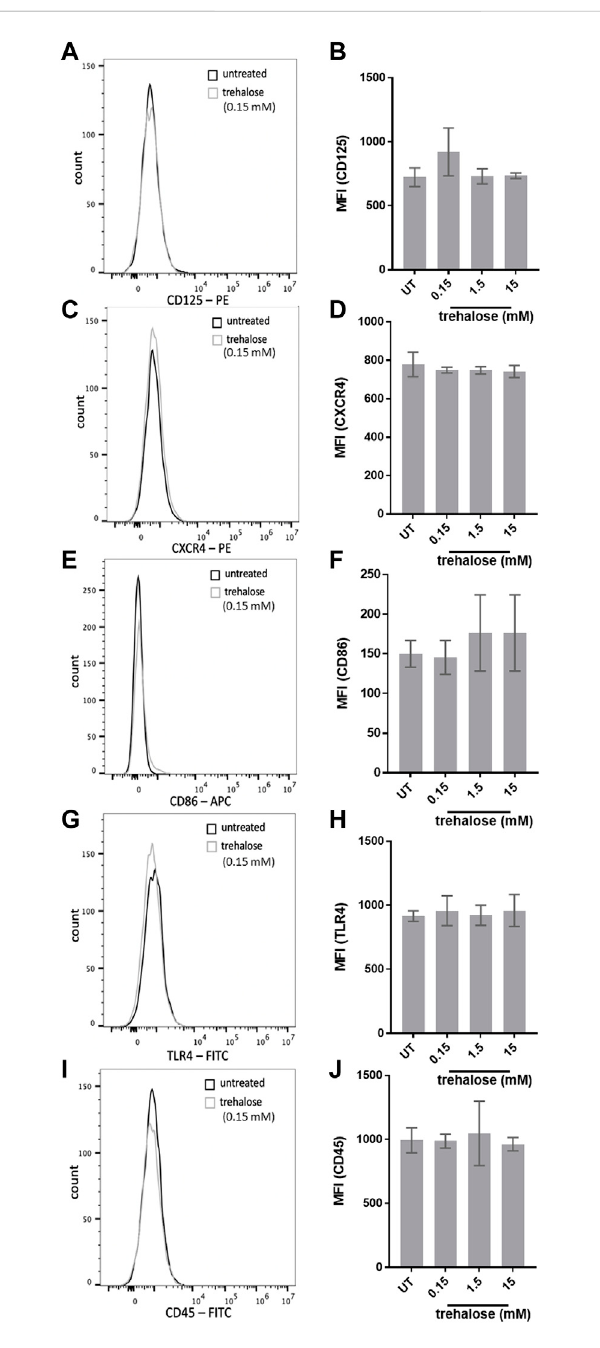
FIGURE 12 Effects of trehalose on HMC3 biomarker expression. Histograms and corresponding bar graphs of HMC3 left untreated or treated with 0.15 – 15 mM of trehalose for 24 h and expression of (A, B) CD125, (C, D) CXCR4, (E, F) CD86, (G, H) TLR4 or (I, J) CD45 was analyzedby fl owcytometry.Datashownin fl owcytometryhistograms is representative of three independent experiments ( n = 3). Mean fl uorescence intensity (MFI) values for all three experiments are presented as mean ± SEM for n = 3. Statistical signi fi cance was calculated using one-way ANOVA with Tukey post hoc